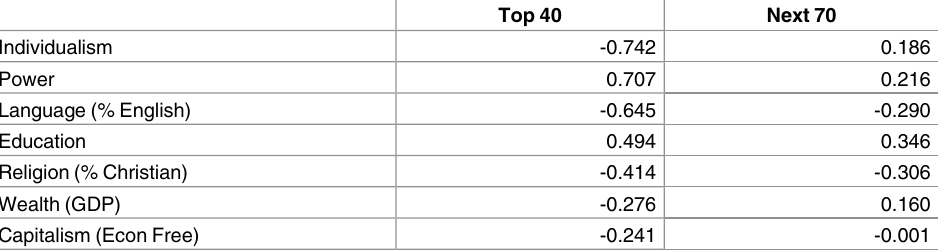
Table 5. Correlations between motivation index and national